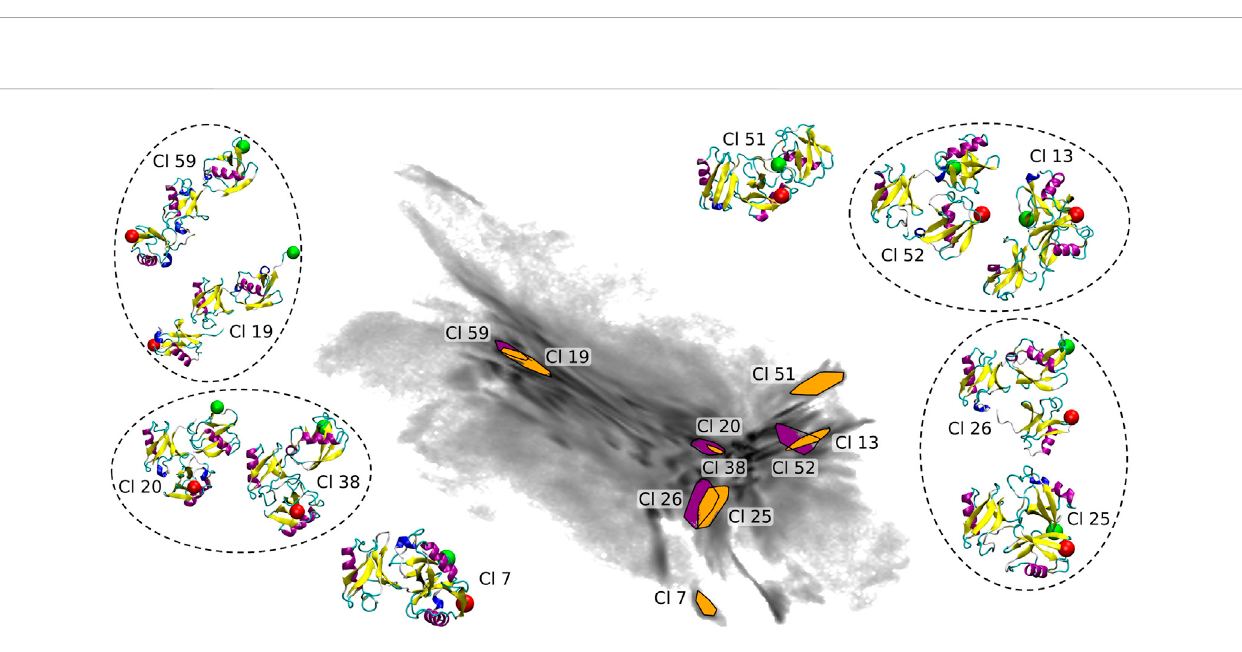
FIGURE 7 SelectedclustersandtheirrepresentativeconformationsintheBMBSprojection(thesameasinFigure6).Inallinsetplotsthemiddlemoietyofthetri-Ub system ispositioned inthesameway.A red sphereisattached to the fi rst residue, indicating theproximalunit,and agreen sphereattached to thelastresidue, indicating the distal moiety. Conformations from clusters overlapping in 2D map are